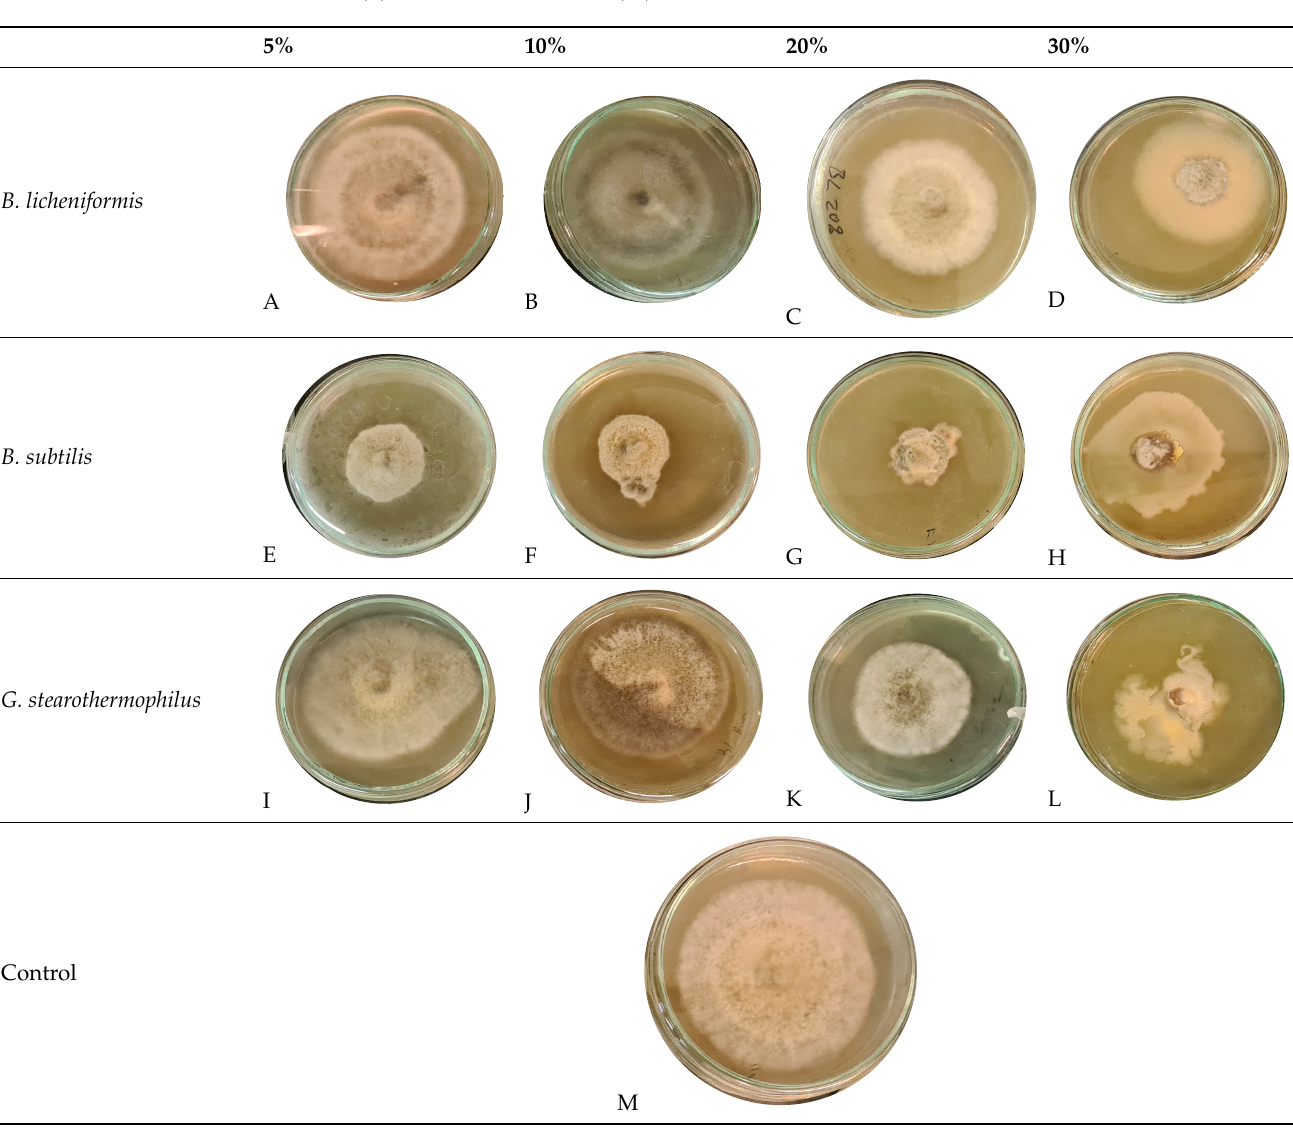
Higher percentages indicate in Table 4. more suppression of mycelial development. The average growth of the control group was 89.68 ± 2.19 mm without any inhibition.